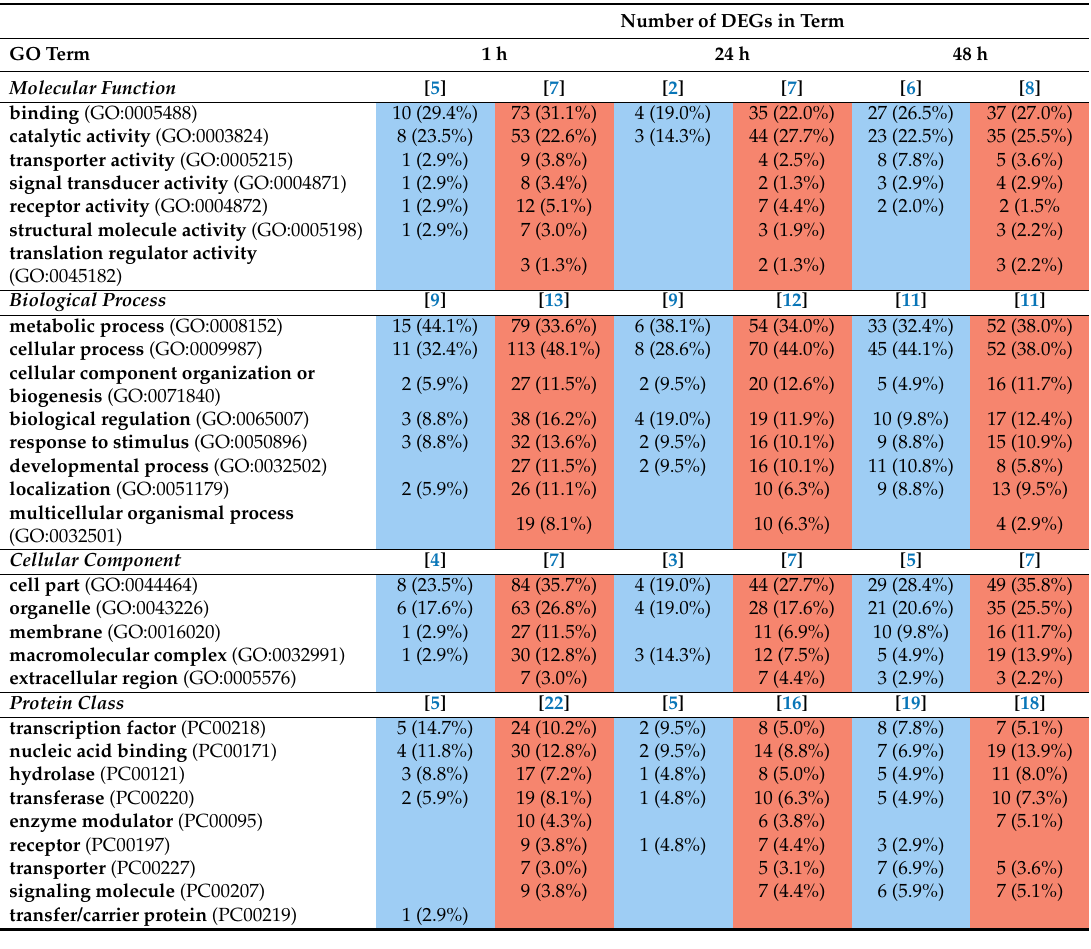
Table 1. Selected significantly overrepresented GO terms upon HDFa treatment with 0.05% DMSO. AmiGO analysis and Panther Classification System defined mostly enriched molecular functions, biological processes, cellular components and protein classes upon 0.05% DMSO HDFa treatment for 1, 24 and 48 h with false discovery rate (FDR) < 0.1, fold change (FC) ≤ 0.7 (blue columns) and ≥ 1.3 (red columns), n = 3 and p < 0.001. Each column represents numbers of DEGs involved in defined term and percentage gene hits against total number of genes (in brackets). Number of all overrepresented GO terms for each time point and class is presented in square